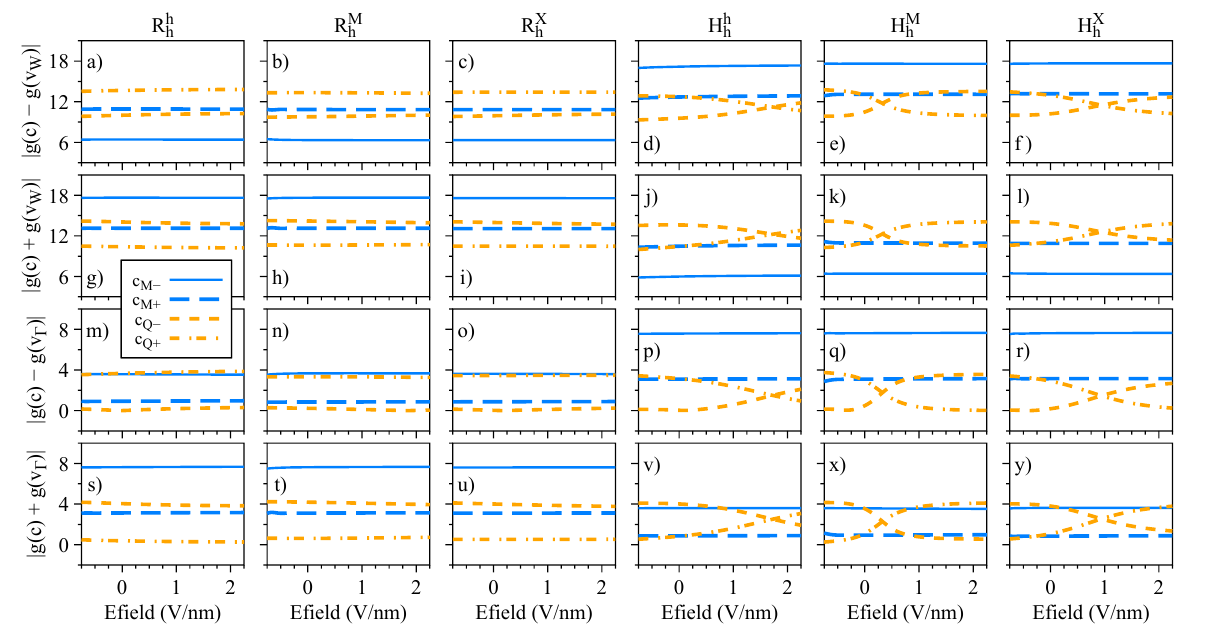
Figure 14. Dipolar exciton g-factors as a function of the electric field for the R- and H-type systems studied for the cases ( a – f ) | g ( c ) − g ( v W ) | , ( g – l ) | g ( c ) + g ( v W ) | , ( m – r ) | g ( c ) − g ( v Γ ) | and ( s – v , x , y ) | g ( c ) + g ( v Γ ) | .